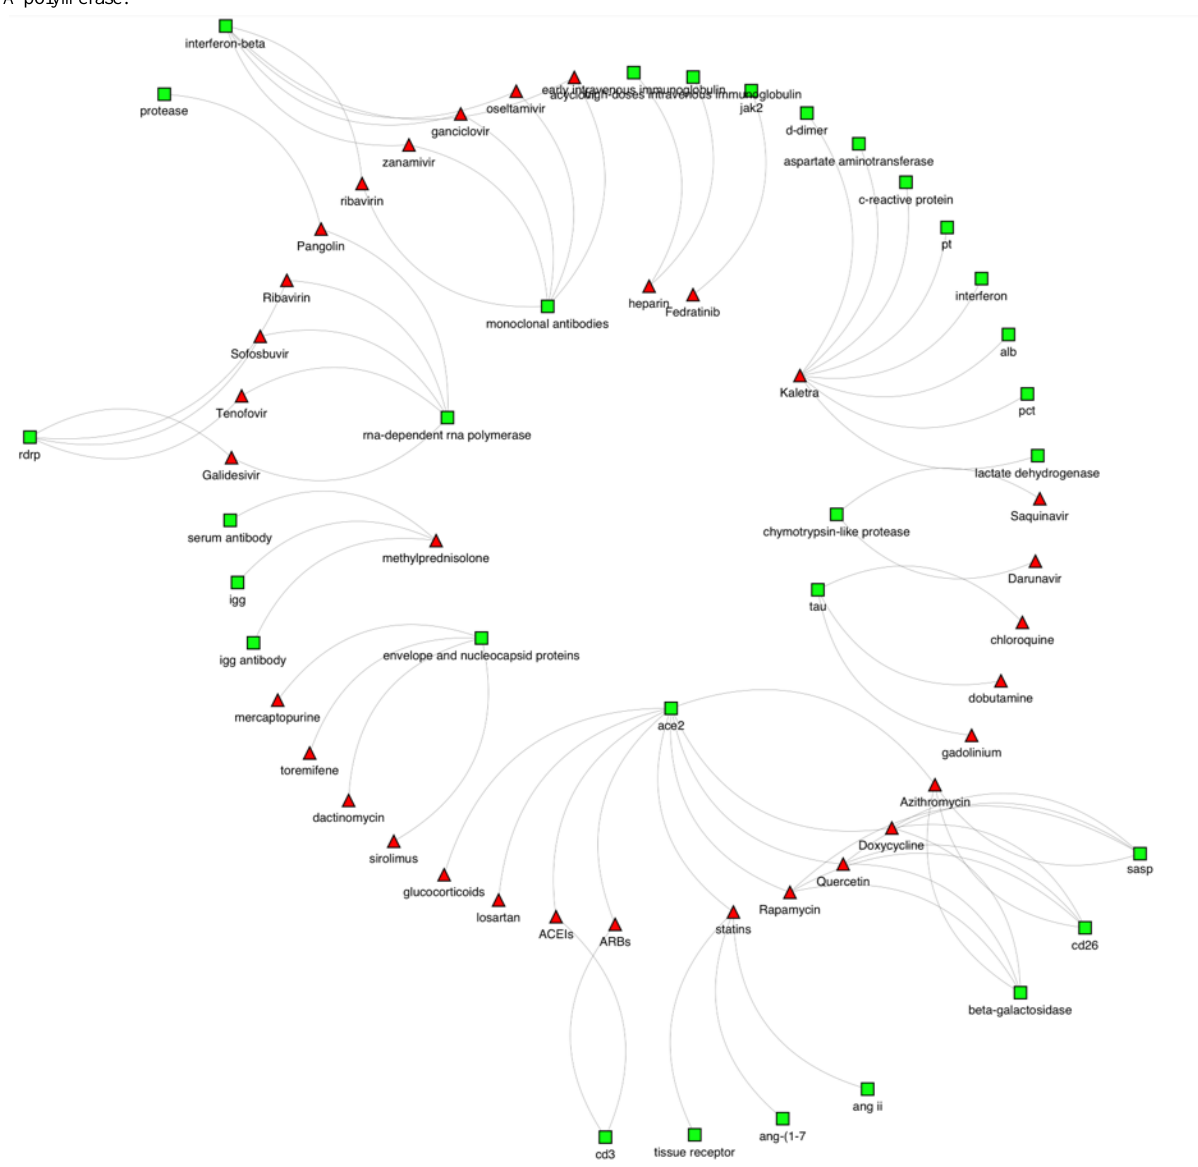
Figure 3. The connections between drugs and protein targets. The drugs nodes are represented as red triangles and the protein nodes are represented by green squares. Here we note that various drugs have targeted one specific protein (ACE2), while other drugs have been found linked to more than one protein as in the case with methylprednisolone. ACEIs: angiotensin-converting enzyme inhibitors; ace2: angiotensin-converting enzyme 2; ang: angiotensin; ANG II: angiotensin II; ARBs: angiotensin II receptor blockers; igg: immunoglobulin G; jak2: Janus kinase 2; RdRp: RNA-dependent RNA